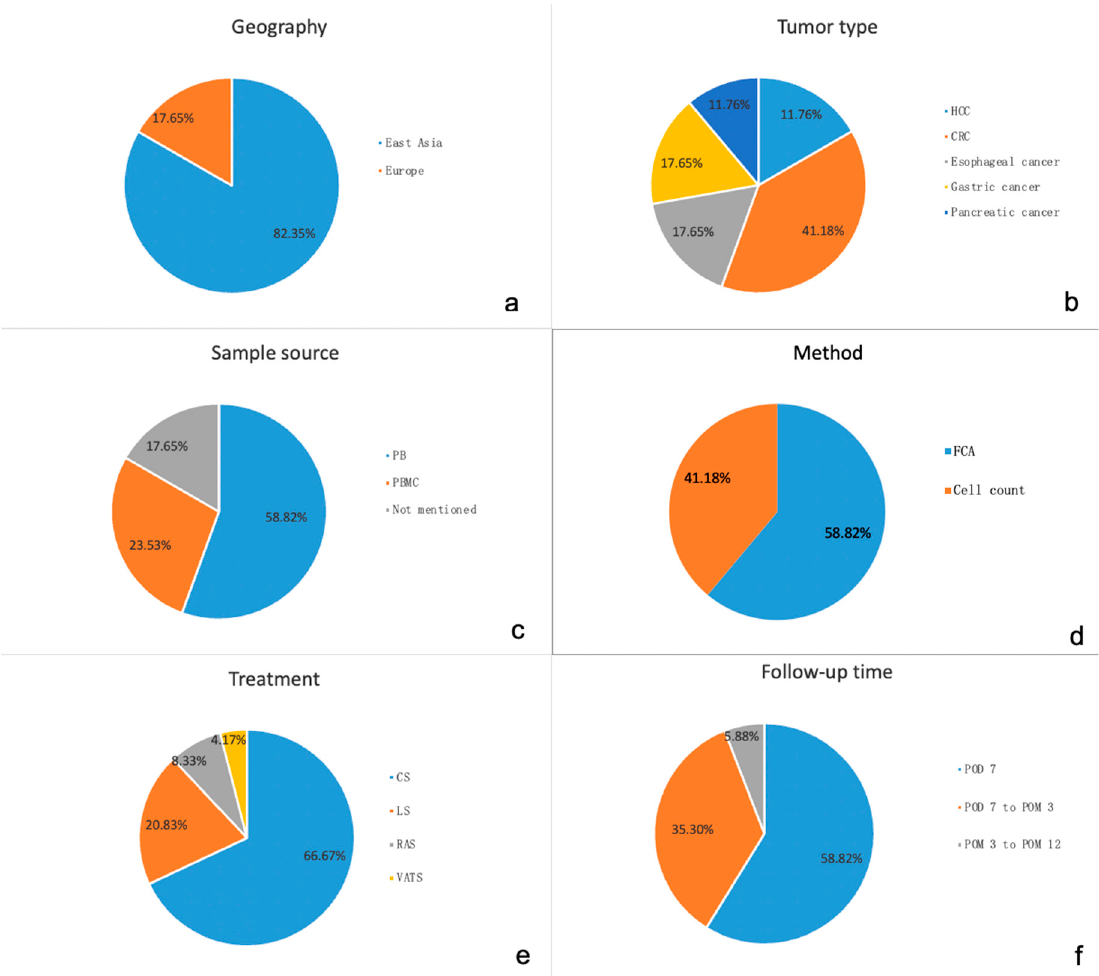
Figure 2. Characteristics of studies included in the analysis. ( a ): geographic distribution of publications; ( b ): classification of digestive system tumors; ( c ): source of the specimen; ( d ): detection methods; ( e ): surgical methods; ( f ): postoperative follow-up time. (Abbreviations: CRC: Colorectal cancer; HCC: Hepatocellular carcinoma; PB: Peripheral blood; PBMC: Peripheral blood mononuclear cells; FCA: Flow cytometry analysis; CS: Conventional surgery; LS: Laparoscopic; RAS: Robot-assisted surgery; VATS: Video-assisted thoracoscopic surgery; POD: Postoperation day; POM: Postoperation month).